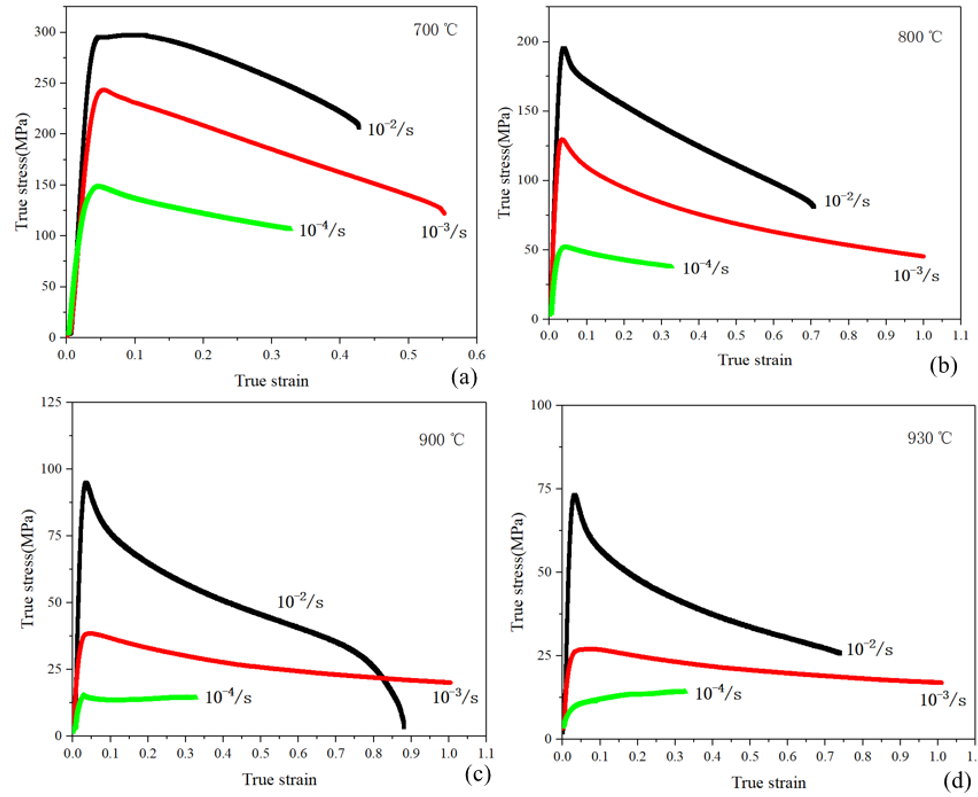
Figure 4. The flow behavior of a Ti-6Al-4V alloy during air cooling at the following temperatures: ( a ) 700 °C; ( b ) 800 °C; ( c ) 900 °C; ( d ) 930 °C.